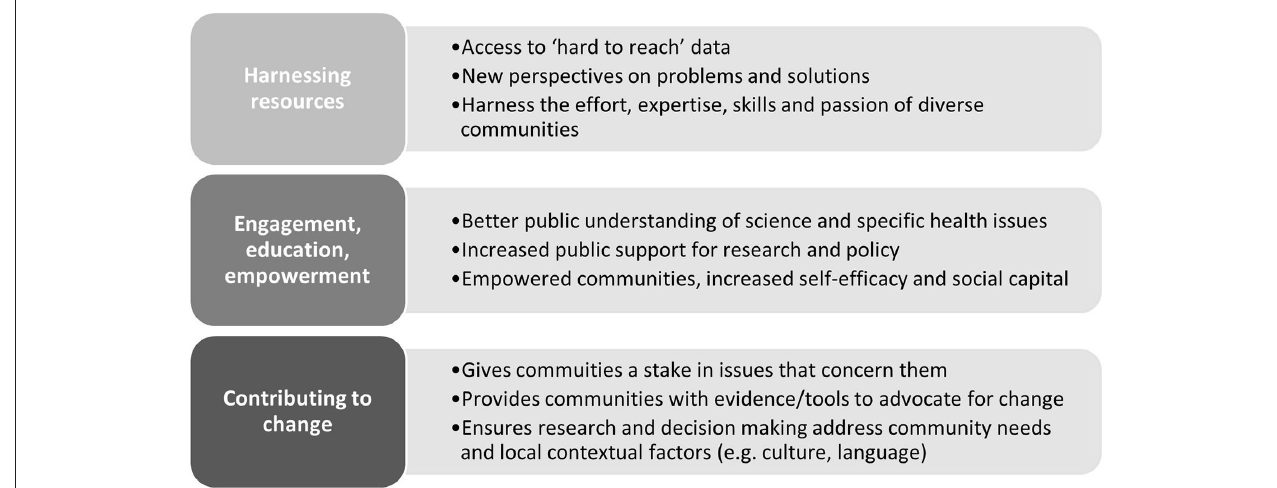
FIGURE 2 | Potential applications of citizen science in chronic disease prevention